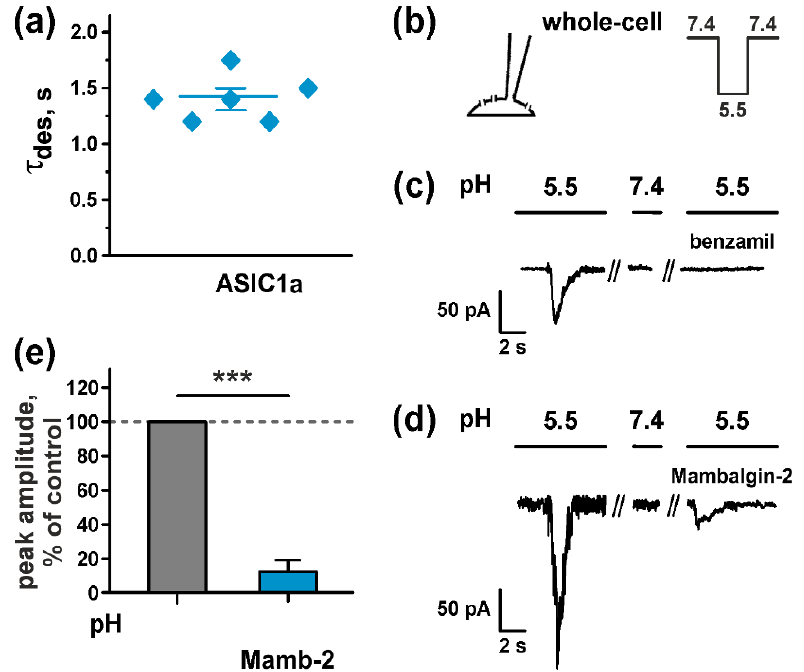
Figure 3. Mambalgin-2 e ff ect on ASIC1a expressed in U251 MG glioma cells: ( a ) Desensitization time constant τ des of ASIC1a. Data are presented as mean ± SEM ( n = 6); ( b ) Whole-cell configuration of the patch clamp technique and protocol of experiment; ( c ) Activation of the ASIC1a currents in U251 MG cells caused by rapid change of the extracellular solution pH from 7.4 to 5.5 (control, on the left), in the solution with pH 7.4 (in the middle), and upon application of 10 µ M benzamil to the extracellular solution with pH 5.5 (on the right); ( d ) Activation of the ASIC1a currents in U251 MG cells caused by rapid change of the extracellular solution pH from 7.4 to 5.5 (control, on the left), in the solution with pH 7.4 (in the middle), and upon application of 1.5 µ M mambalgin-2 to the extracellular solution with pH 5.5 (on the right); ( e ) Influence of 1.5 µ M mambalgin-2 application to the extracellular solution with pH 5.5 on the peak amplitude of the ASIC1a currents in U251 MG cells. Data are presented as normalized peak current amplitude, % of control ± SEM ( n = 3). Control level (100%, untreated cells) is shown by dashed line. *** ( p < 0.001) indicates significant di ff erence from the control according to two-sided t -test.